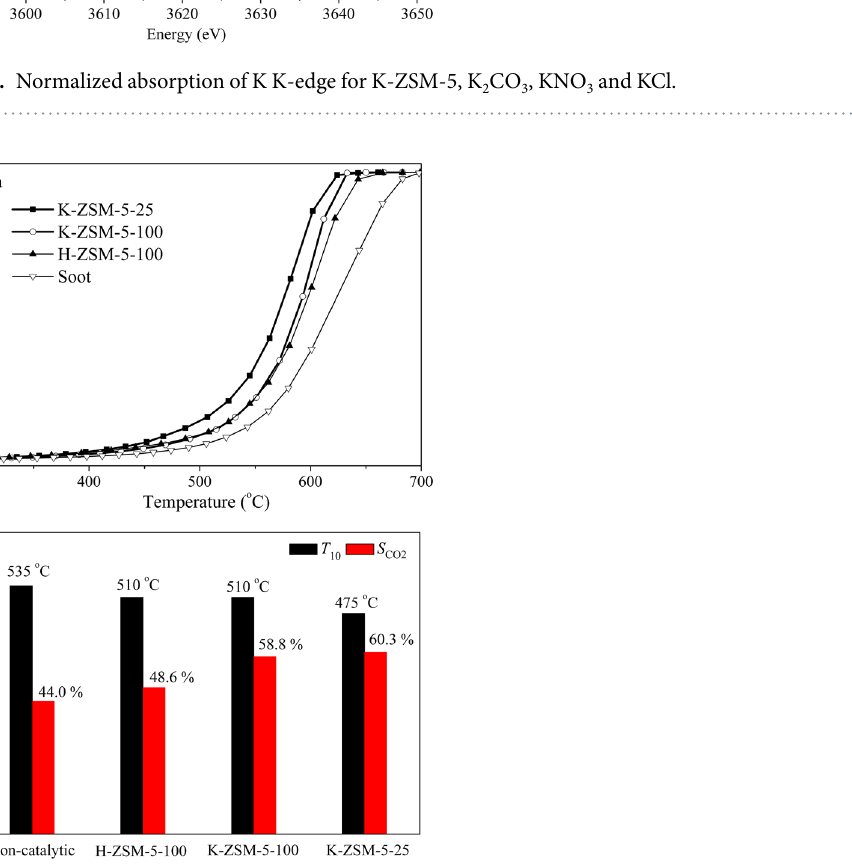
Figure 4. Catalytic performance for soot combustion. ( a ) Soot conversion (%) versus temperature, and ( b ) T 10 and S for un-catalyzed, H-ZSM-5-100, K-ZSM-5-100 and K-ZSM-5-25 CO 2